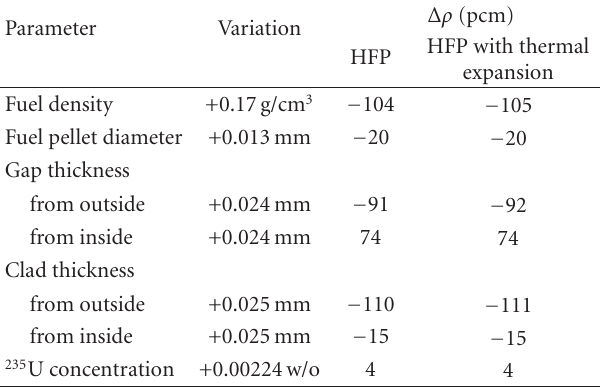
Table 10: Manufacturing sensitivities for TMI-1 at HFP conditions considering thermal expansion.